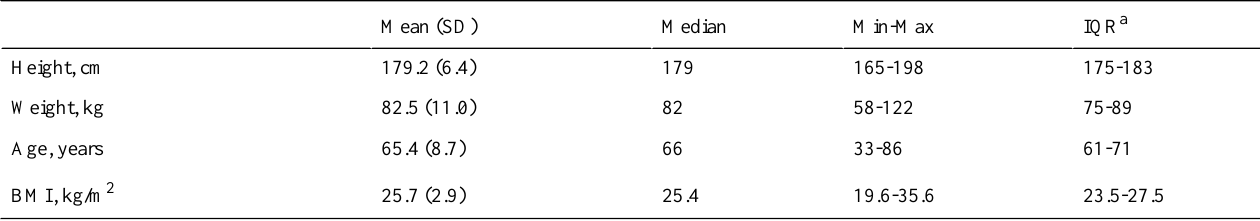
Table 2. Characteristics of study participants